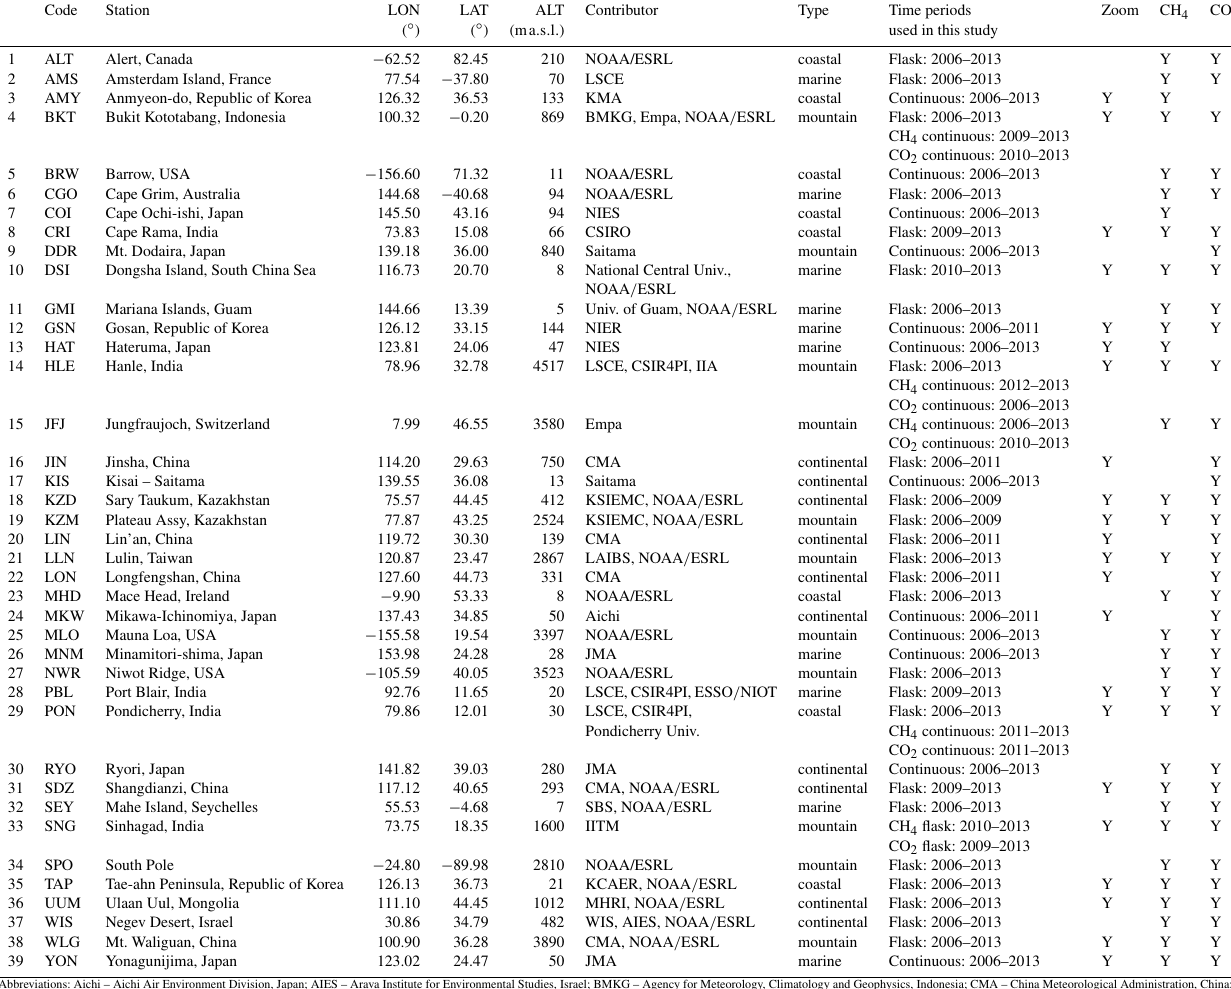
Table 2. Stations used in this study. For the column “Zoom”, “Y” indicates a station within the zoomed region.